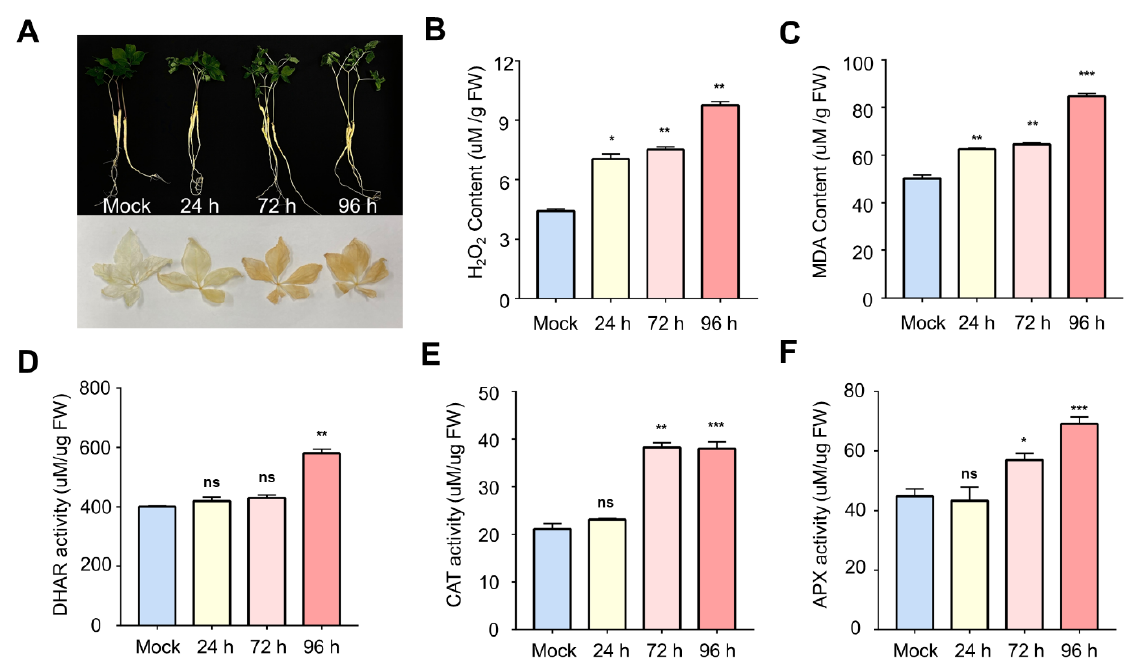
Figure 1. ( A ) Effect of salt stress on ginseng (upper panel) and accumulation of ROS as observed by DAB staining (lower panel). Measurement of ( B ) H 2 O 2 , and ( C ) lipid peroxidation contents and antioxidant enzyme activities of ( D ) DHAR, ( E ) CAT, ( F ) APX at Mock, 24 h, 72 h, and 96 h following salt stress. The bars show mean values ± standard deviations summarized from individual values in independent experiments ( n = 3). Significant differences between mock and salt-treated samples are highlighted by an asterisk. (ns indicates not significance, * indicates significance of p < 0.05, ** indicates significance of p < 0.01, *** indicates significance of p < 0.001).